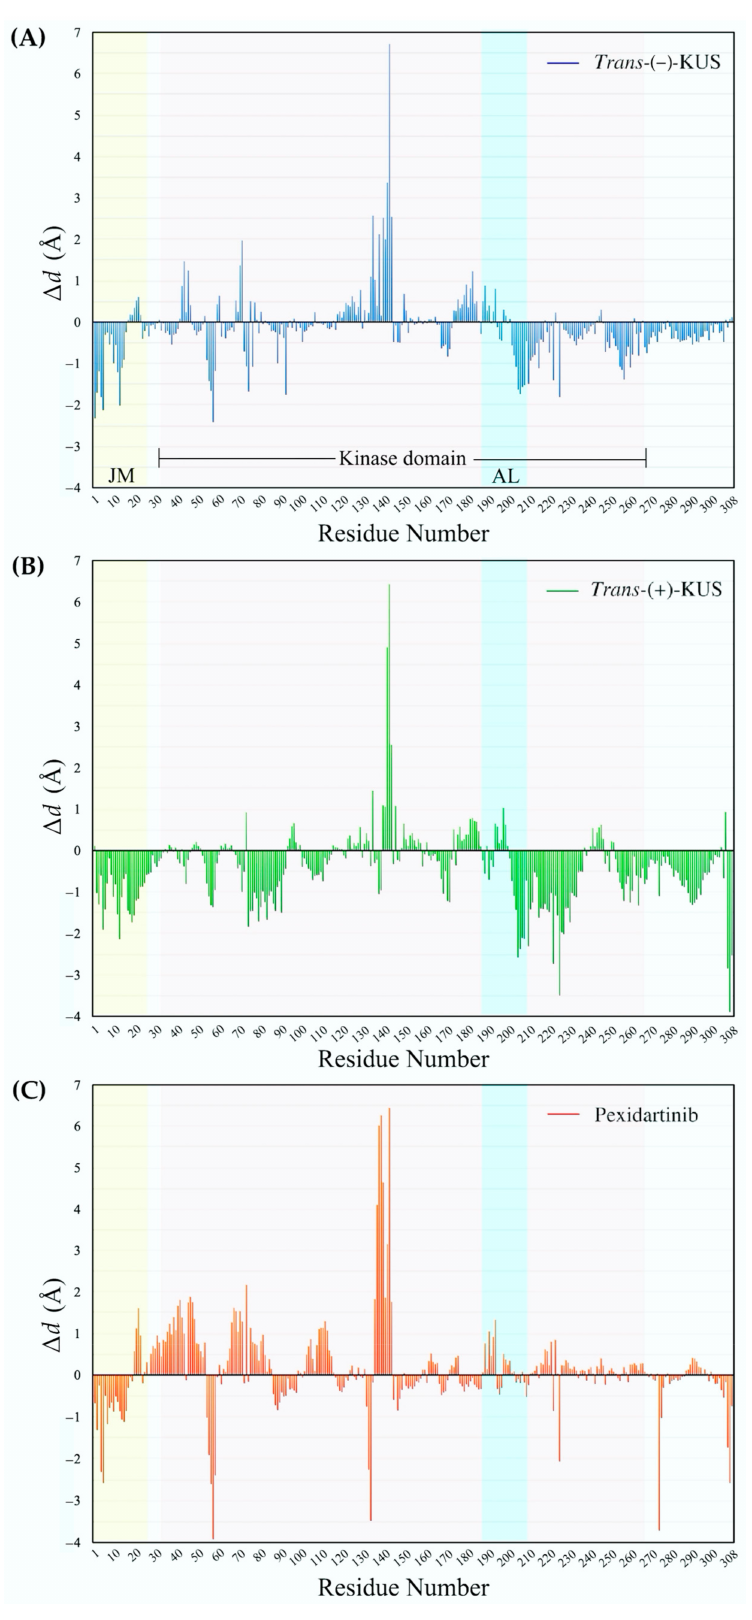
Figure 10. Pattern of distance difference of ligand-bound CSF1R with respect to the ligand-free state: ( A ) distance pattern of trans -( )-kusunokinin-bound CSF1R; ( B ) trans -(+)-kusunokinin-bound CSF1R; − ( C ) pexidartinib-bound CSF1R, aligned with the CSF1R-unbound structure.